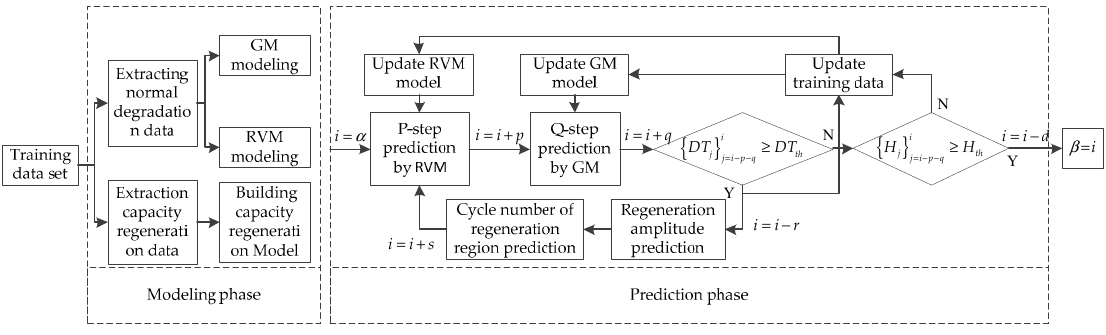
Figure 3. The framework of the hybrid RVM and GM model (RVM-GM) prediction method.